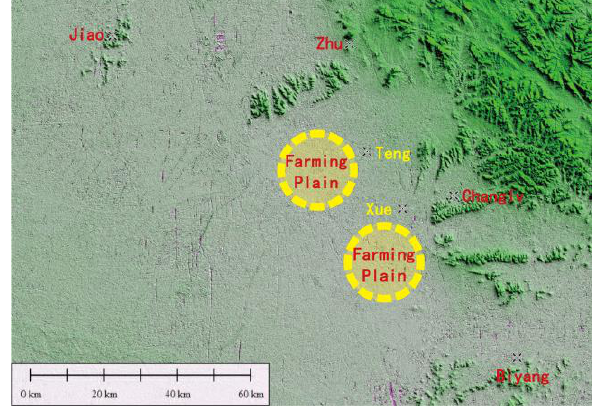
Figure 23. The situation analysis of Xue and Teng Xue was stronger than Teng, however, Teng implemented “kind governance” and ruled for a longer time instead.